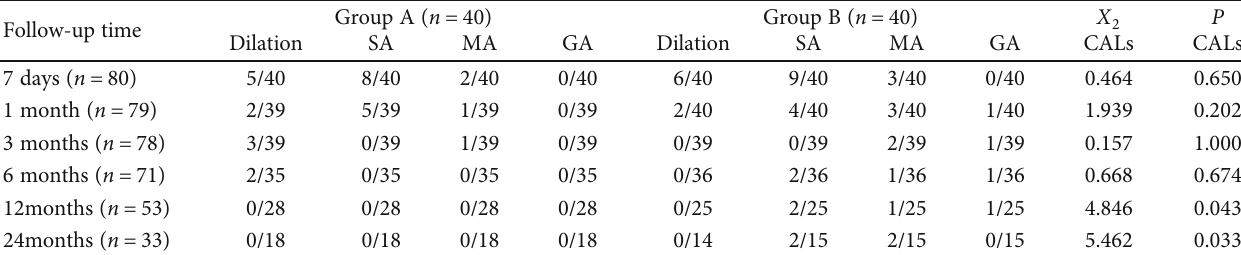
Table 3: CALs in the two